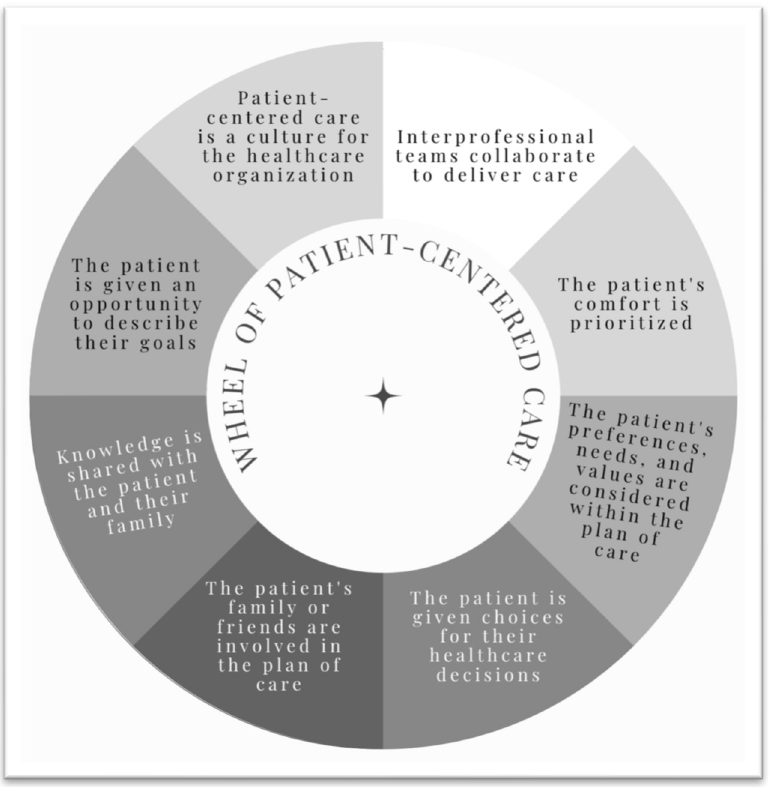
Figure 1. Wheel of patient-centered care [1,3–6].